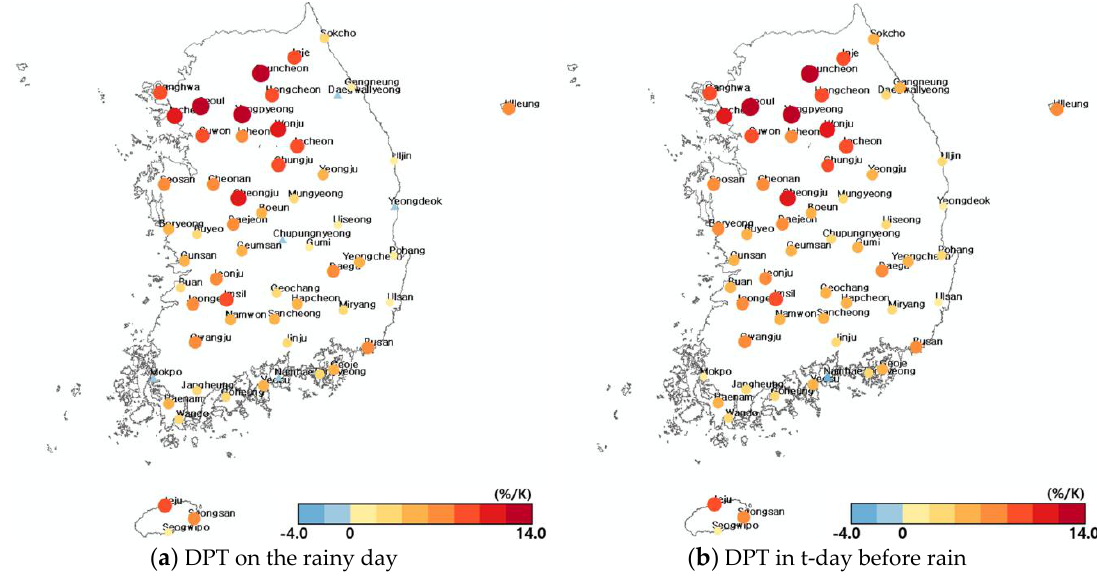
Figure 3. Sensitivity of 95% daily rainfall depth to DPT in all sites.